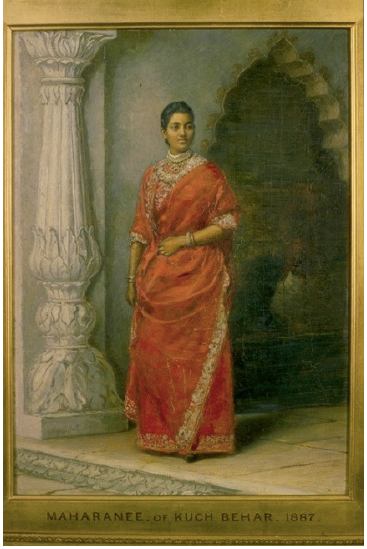
Figure 4. Sydney Prior Hall, The Maharani of Cooch Behar